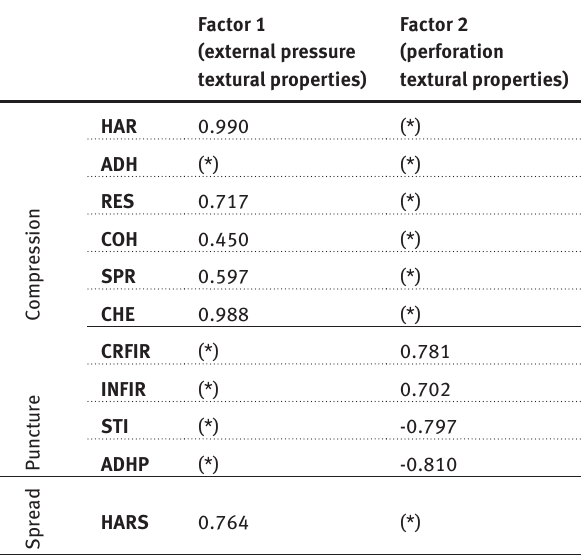
Table 4: Component matrix obtained by factor analysis with Varimax rotation Factor